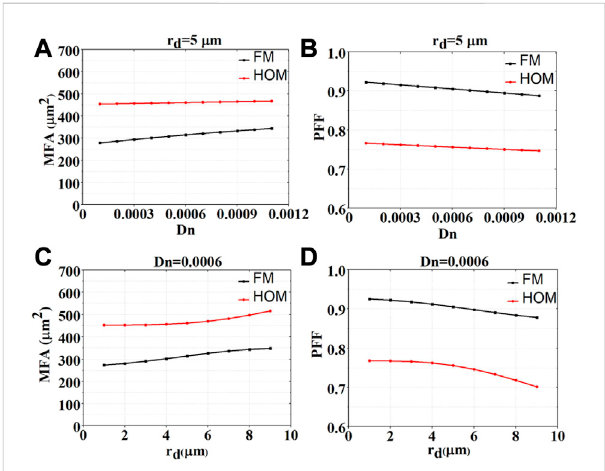
FIGURE 2 The relation between the mode fi eld parameter and the dip parameter. (A) MFA as a function of dip depth; (B) PFF as a function of dip depth; (C) MFA as a function of dip radius; (D) PFF as a function of dip